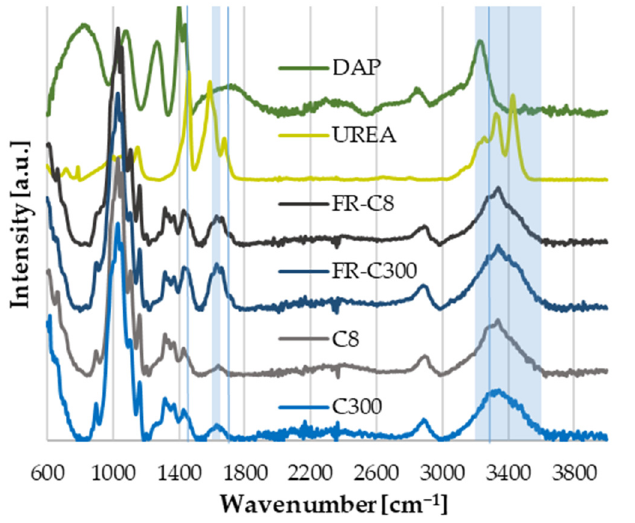
Figure 4. ATR-FTIR spectra of C8 and C300 before and after FR-treatment.